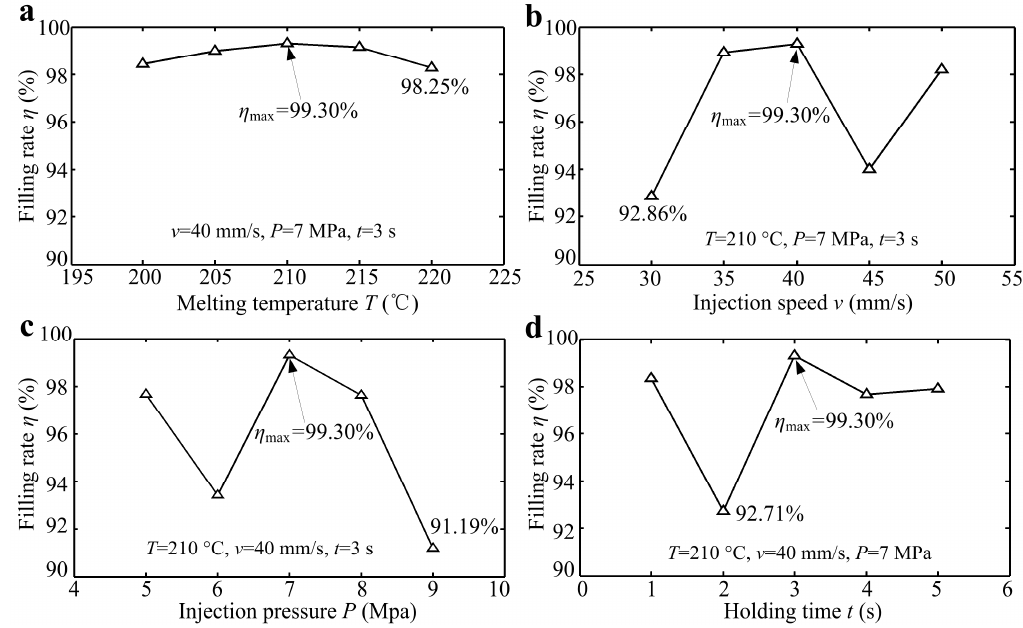
Figure 13. The filling rate of micro-structured polymer η versus micro injection molding parameters: ( a ) Melting temperature T ; ( b ) injection speed v ; ( c ) injection pressure P ; ( d ) holding time t .